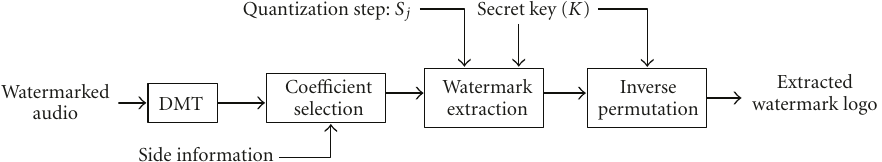
Figure 5: Watermark extracting process.